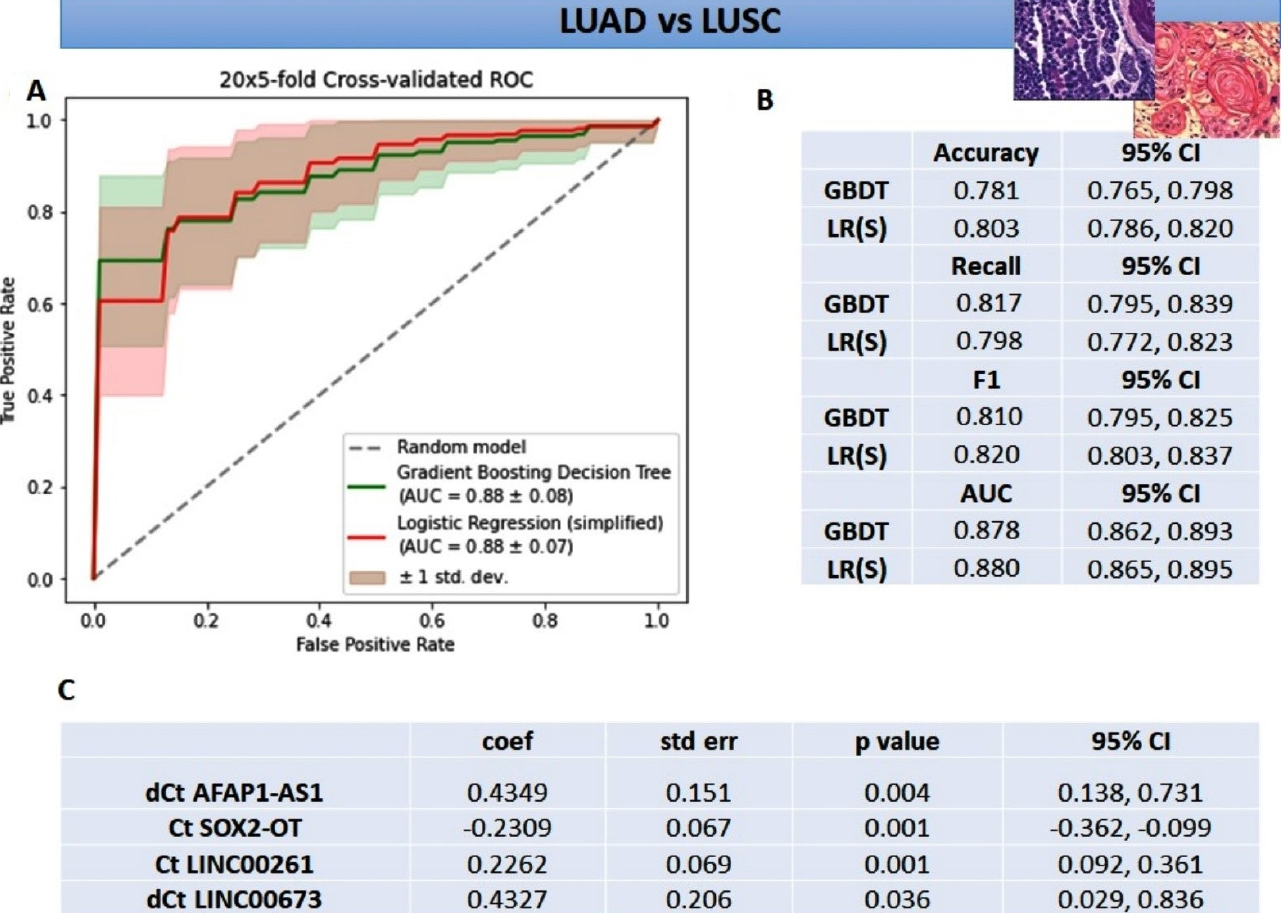
Figure 3. Metrics for gradient boosting decision tree and simplified logistic regression classifiers for differentiating LUSC tissue from LUAD tissue: ( A ) mean ROC ± SD curve, and mean AUC for the two classifiers; ( B ) mean and 95% CI of precision, recall, f1-score metrics, and AUC; ( C ) summary table with coefficients and significance for the simplified logistic regression classifier; GBDT—gradient boosting decision tree, LR(S)—logistic regression (simplified).